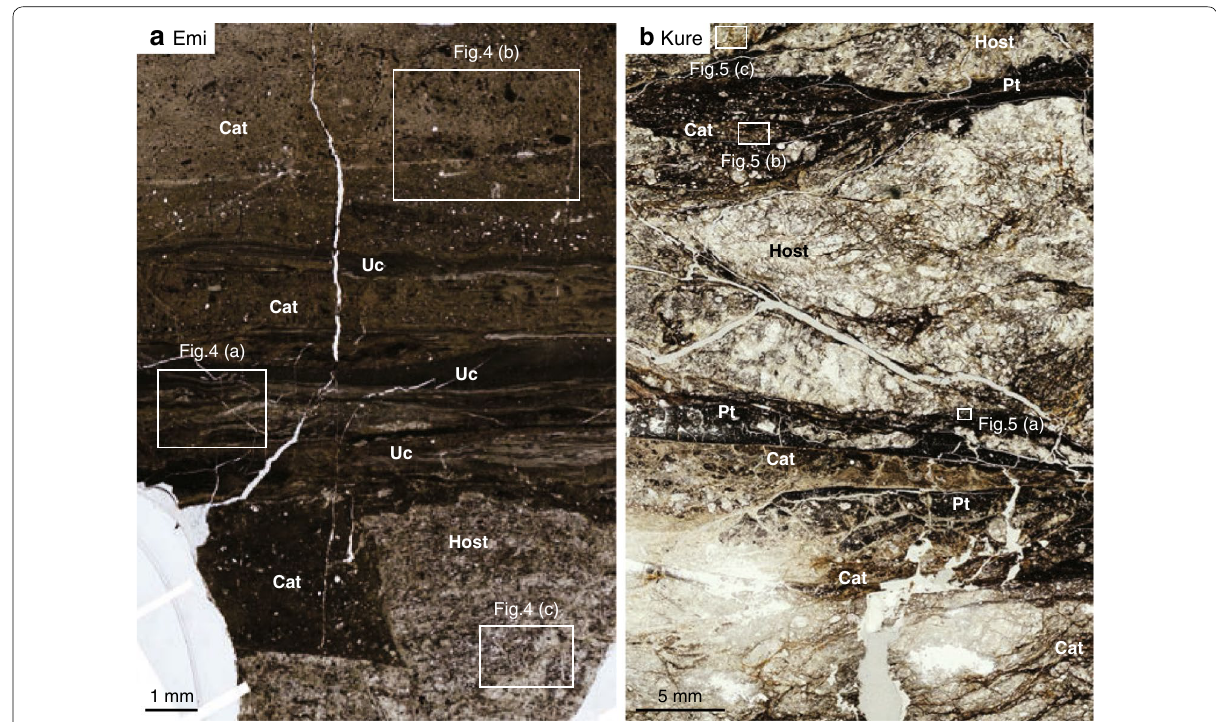
Fig. 3 Photomicrographs showing microstructures in discrete slip zones. a The Emi major thrust and b the Kure OST. Uc ultracataclasite, Cat catacla- site, Host host rock, Pt